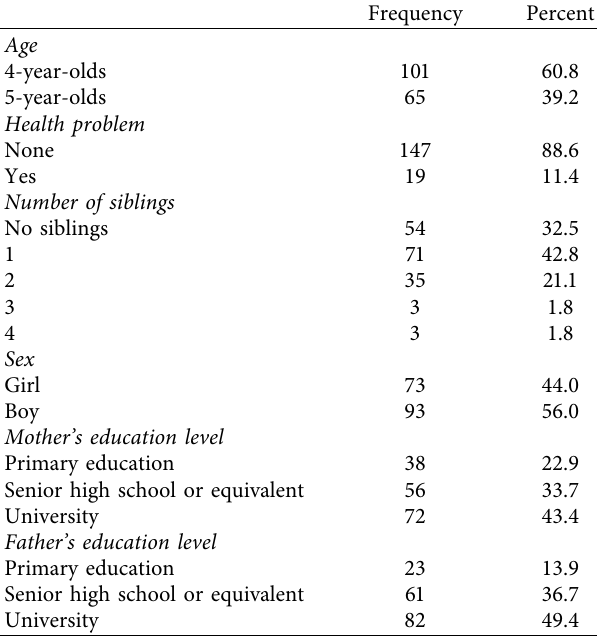
Table 7: Breakdown of demographic